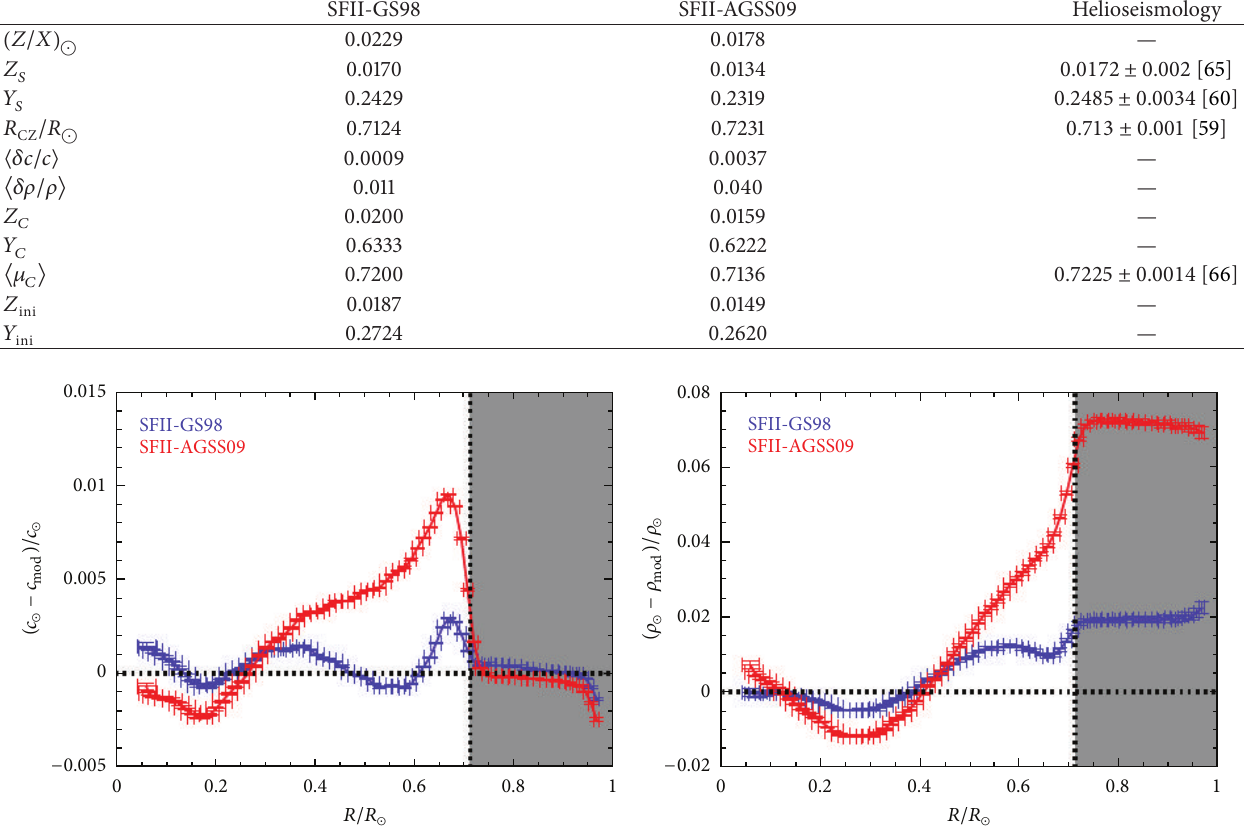
Figure 1: Sound speed and density relative differences between solar models and the Sun as determined from helioseismic inversions [72]. The convective envelope is depicted by the grey